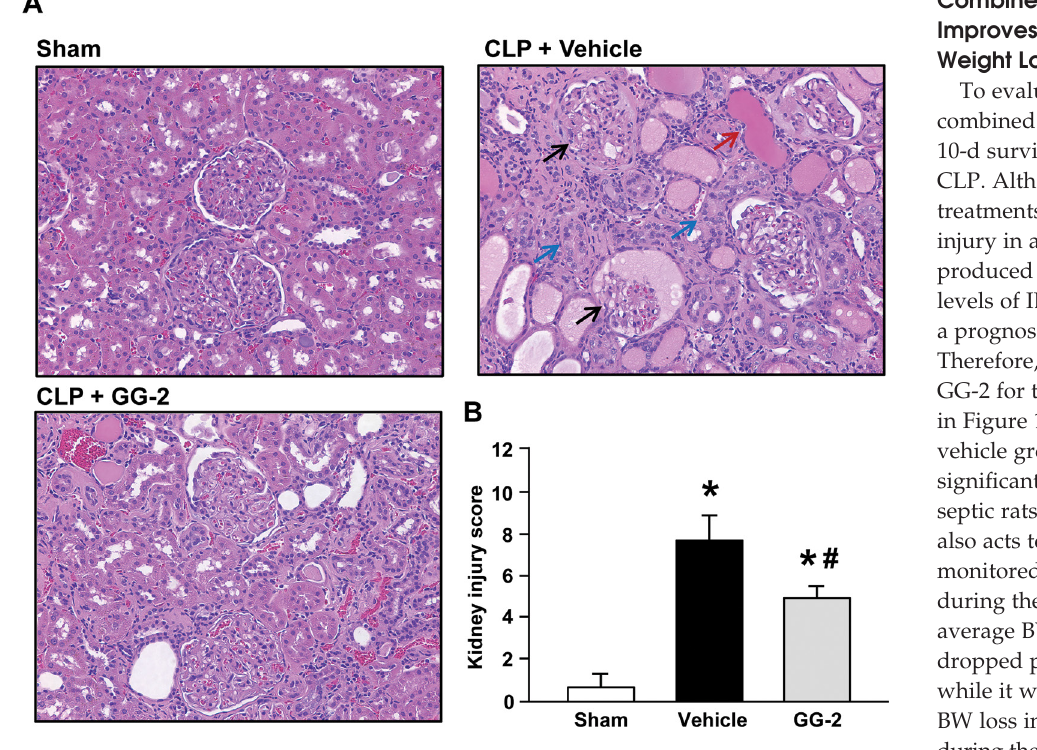
Figure 6. Effect of the combined treatment on the morphological structure of kidney tissues in aged septic rats. Rats were sham operated or subjected to CLP with injection of vehicle (normal saline) or GG-2 (80 nmol/kg of ghrelin and 50 μ g/kg of GH) at 5 h after CLP. The kidney tissues were harvested at 20 h after CLP. Sections of kidney tissues were stained with H&E and examined under light microscopy. (A) Representative images of the stained kidney tissues are shown. The kidneys obtained from the vehicle group demonstrated a sig- nificant renal injury with glomerular destruction (black arrow), tubular proteinaceous casts (red arrow), loss of tubular brush borders and epithelial cell injury (blue arrows). The integrity of renal morphology in the GG-2 treatment group is significantly improved. Original magni- fication 200×. (B) Histologic injury scores of the kidney in different groups were quantified as described in Materials and Methods. Data are expressed as mean ± SE (n = 5–7 per group). * P < 0.05 versus sham and # P < 0.05 versus